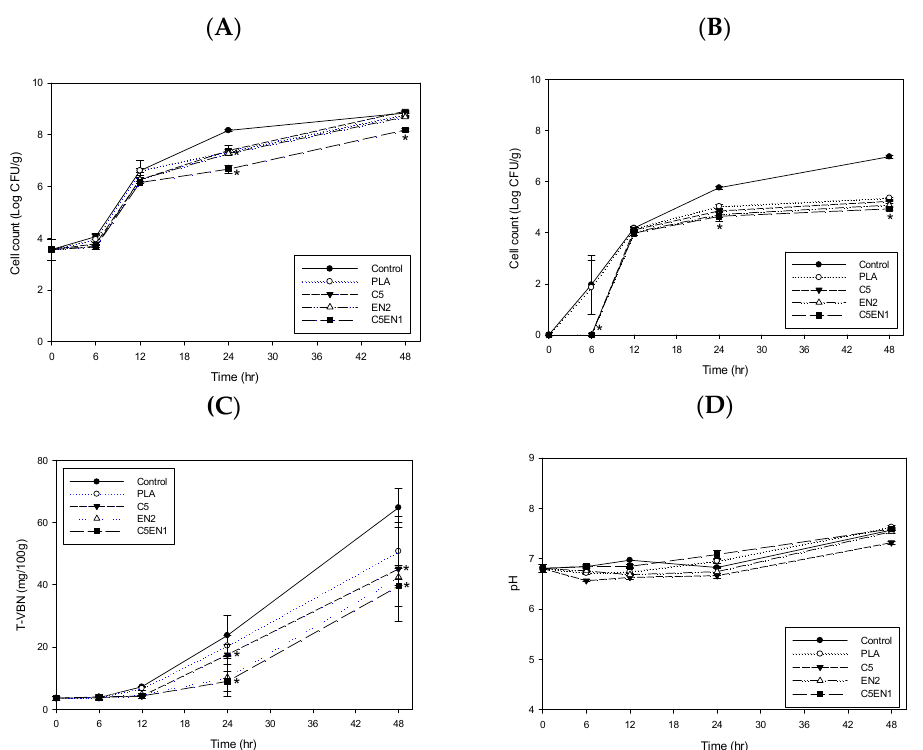
Figure 4. Changes in mesophilic bacteria count ( A ), psychrotrophic bacteria count ( B ), total volatile basic nitrogen content (TVBN) ( C ) and pH value ( D ) of fish fillet ( Epinephelus fuscoguttatus x Epinephelus lanceolatus ) covered with PLA, C5, EN2, or C5EN1 film during 25 ◦ C storage for 48 h. PLA, PLA film as control; C5, PLA + 0.5% chitosan; EN2, PLA + 20 mM EDTA + 0.02% nisin; C5EN1, PLA + 0.5%chitosan + 20 mM EDTA + 0.01% nisin. Data are presented as mean ± SD (n = 3). * means significantly different, compared to control ( p < 0.05).